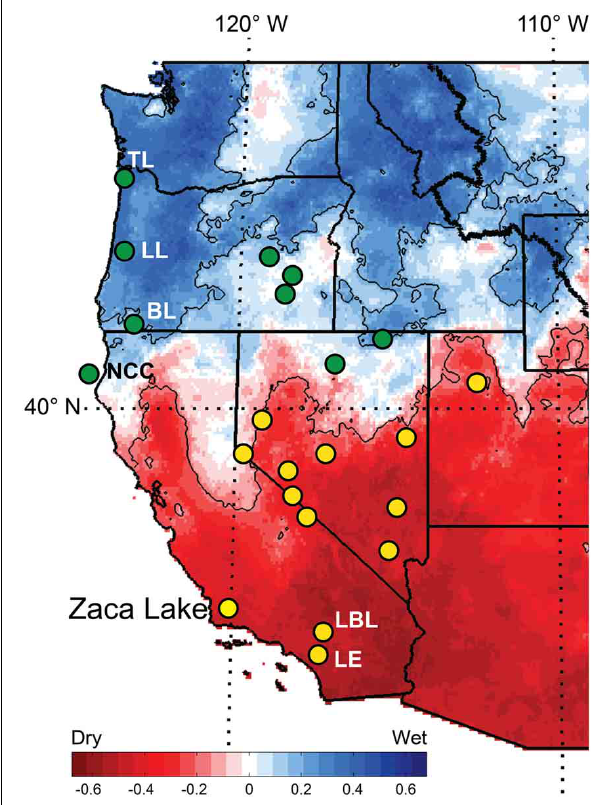
FIGURE 10 | Spatial distribution of study sites from the western United States showing dry (yellow circles) and wet (green circles) sites during the period between 2700 and 2000 cal yr BP (unlabeled sited adapted from Mensing et al., 2013). Background shows correlation coefficients between Jun-Nov SOI and Oct-Mar precipitation, 1926–2007 (adapted from Wise, 2010). Correlations significant at the.01 level are highlighted and contoured. Labeled sites: BL [Bolan Lake (Briles et al., 2005)]; LBL [Lower Bear Lake (Kirby et al., 2012)]; LE [Lake Elsinore (Kirby et al., 2010)]; NCC [North Coast California (Barron et al., 2013)]; TL [Taylor Lake (Long and Whitlock,